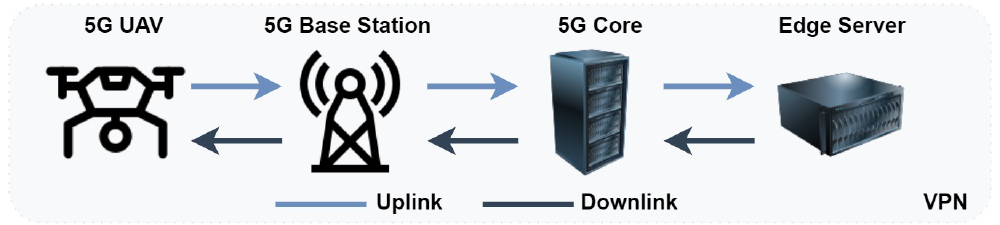
Figure 2. The 5G-UAV (UE) communication system